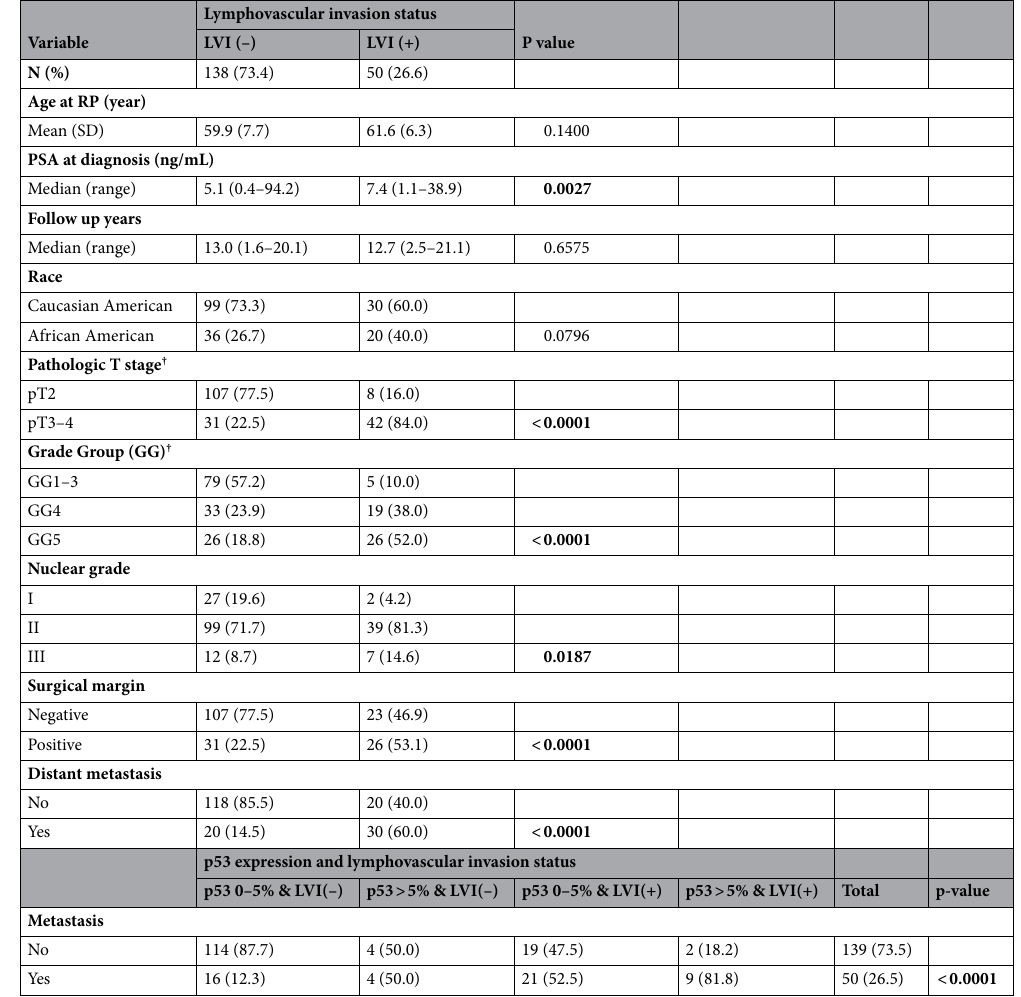
Table 2. Associations of lymphovascular invasion and p53 expression status with demographic and clinicopathological variables. Significant values (P-value < 0.05) are in bold. † Appropriate staging was not possible in one patient due to unavailability of capsular incision